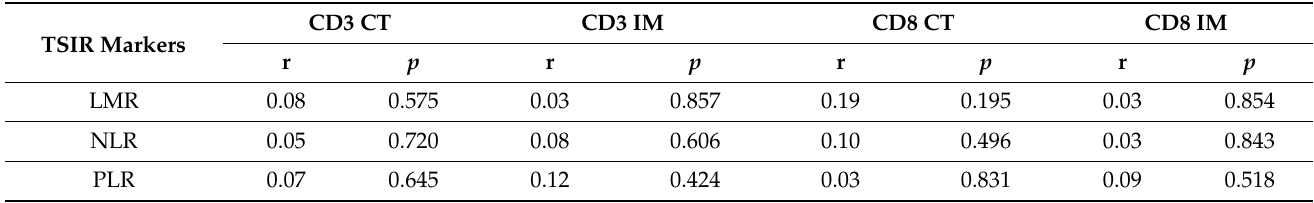
Table 4. Correlation between LMR, NLR, PLR and CD3+ and CD8+ TILs in CT and IM.